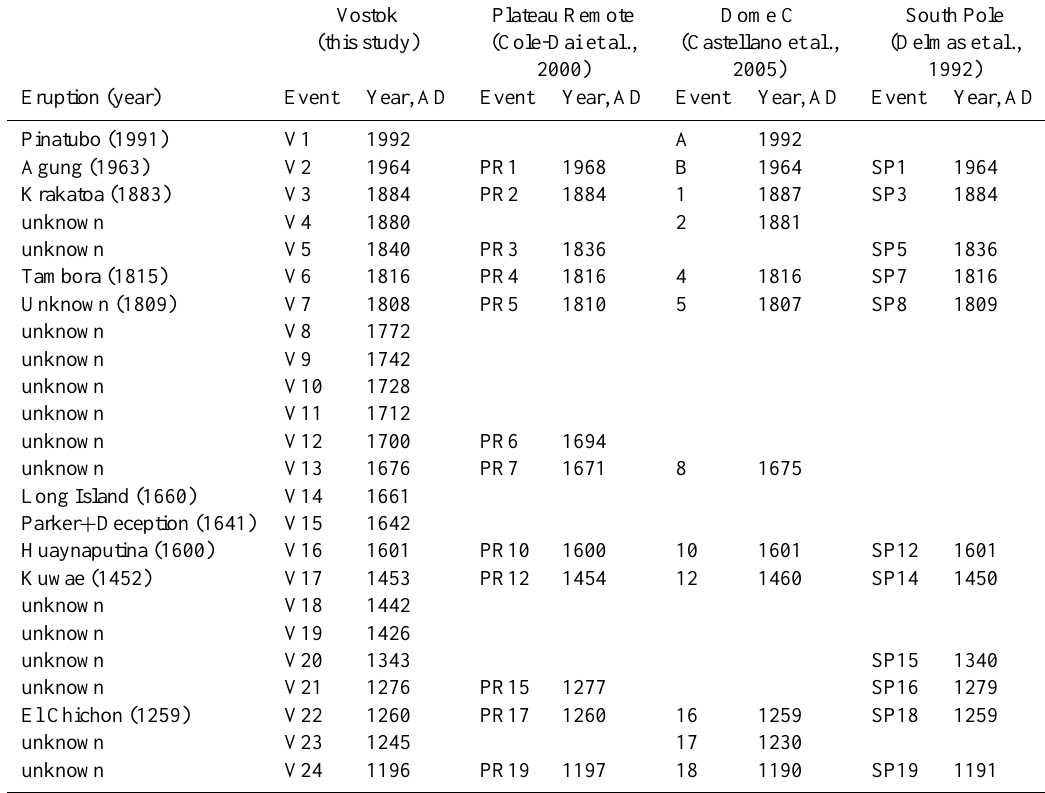
Table 4. Correlation of volcanic events of the Vostok record with other cores in East Antarctica. Vostok Plateau Remote Dome C